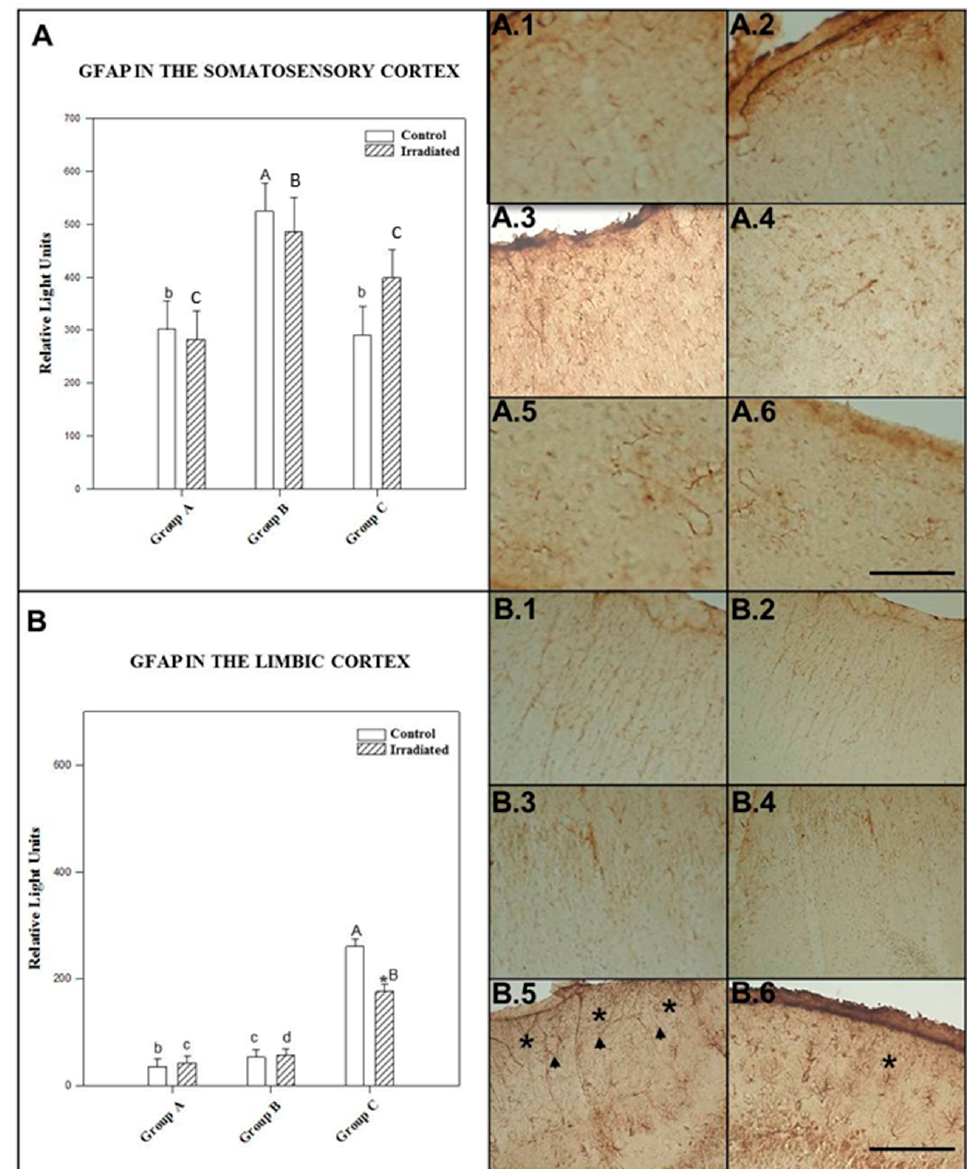
Figure 5. Glial fibrillary acidic protein (GFAP) levels detected by ELISA in the somatosensory cortex ( A ), the limbic cortex ( B ), 1.5 h (Group A) and 24 h (Group B) after acute exposure and 1.5 h after final repeated exposure (Group C) to a 2.45 GHz signal at 0 and 3 W. Each bar represents mean ± SEM. ( n = 24 samples/per group) Asterisks (*) indicate statistically significant differences ( p < 0.05) between the irradiated and control for each group. a, b, c, d indicate statistically significant differences ( p < 0.05) between irradiated or nonirradiated animals comparing between the different groups A, B, C, which were determined using two-way ANOVA followed by the Holm-Sidak test for multiple comparisons. The photographs show the GFAP immunomarkers for groups A, B and C in the somatosensory cortex, control (A.1, A.3 and A.5) and irradiated animals (A.2, A.4 and A.6); in the limbic cortex, control (B.1, B.3 and B.5) and irradiated animals (B.2, B.4 and B.6) ( n = 15 samples/per group). In the photos it is indicate with the arrowhead and asterisk that means increase on regional cytolocalization. Scale bar = 60 µm.